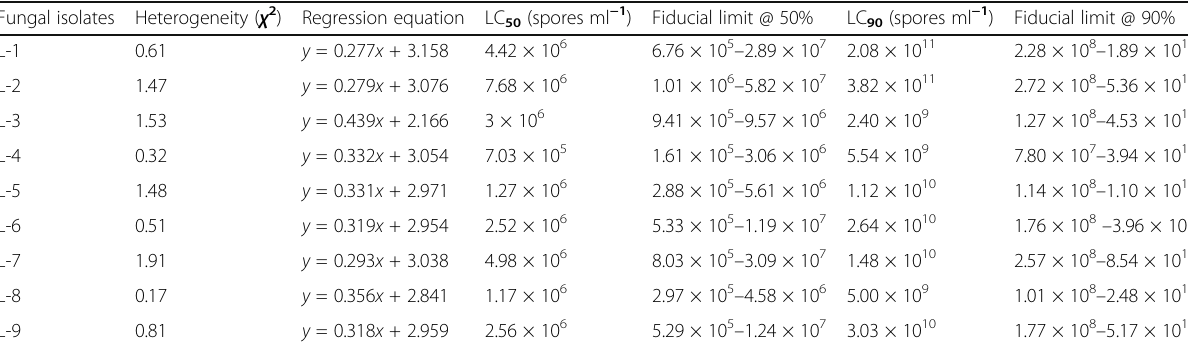
Table 2 Mortality response of 3rd instar larvae of Spodoptera litura to different fungal isolates of Lecanicillium lecanii Fungal isolates Heterogeneity ( χ 2 ) Regression equation LC 50 (spores ml − 1 ) Fiducial limit @